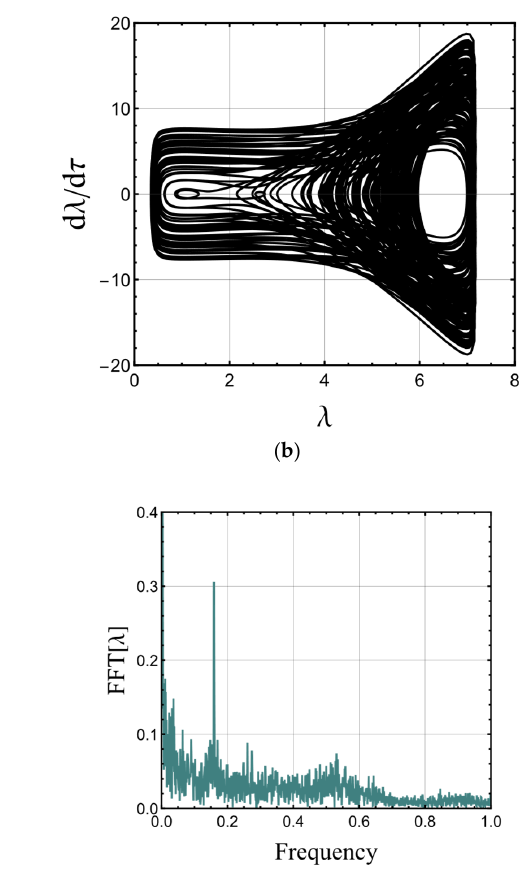
( d ) Figure 5. The dynamic response of the electro ‐ magneto ‐ active polymer to time ‐ varying voltage 𝐻(cid:3365) (cid:3404) 𝐻(cid:3365) (cid:2903) (cid:3404) 0 . ( a ) Time history, ( b ) phase plane diagram, ( c ) Poincaré map, and ( d ) FFT. The effect of varying the static magnetic field and parameters 𝐾 , 𝑐 , and 𝐽 (cid:3040) on the dynamics of the MDE membrane under time ‐ varying voltage is also investigated. For in ‐ stance, Figure 6 presents results for 𝐻(cid:3365) (cid:2903) (cid:3404) 0.4 , 𝐾 (cid:3404) 0 , 𝑆̅ (cid:3404) 𝑆̅ (cid:2903) (cid:3404) 0 , 𝑉(cid:3364) (cid:2888)(cid:2887) (cid:3404) 0.5 , (cid:3023)(cid:3365) (cid:3133)(cid:3135) (cid:3023)(cid:3365) (cid:3136)(cid:3135) (cid:3404) 0.3 , Ω (cid:3404) 1 , 𝑐 (cid:3404) 0 , and 𝐽 (cid:3040) (cid:3404) 100 . The results show that the applied static magnetic field 𝐻(cid:3365) (cid:2903) substantially contributes to the vibration response of the MDE membrane. What stands out from Figure 6 is that with the increase in the static magnetic field 𝐻(cid:3365) (cid:2903) from 0 to 0.4, the quasiperiodic oscillation is replaced by chaotic oscillation. Irregular and unpredictable